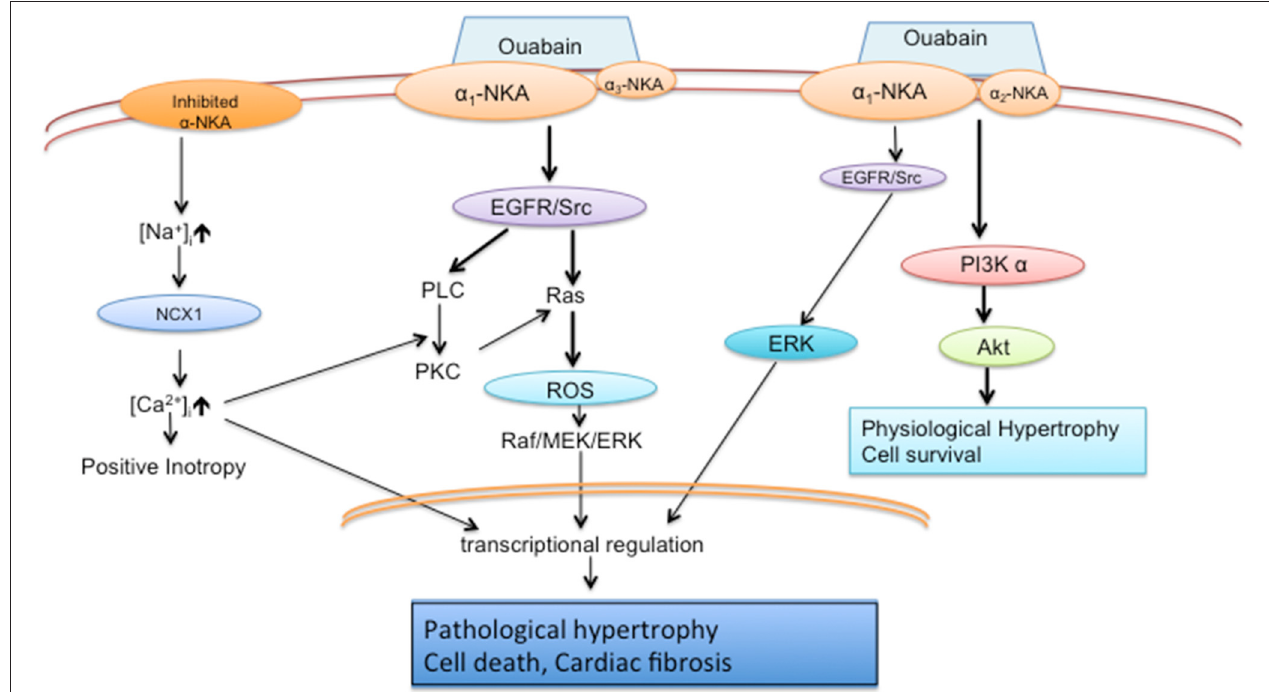
FIGURE 1 | Schematic diagram of Na + /K + -ATPase pumping and signaling functions in cardiomyocytes (Liu et al., 2006, 2007; Wu et al., 2015). Inhibited pump alters local [Na + ] i and induces myocytes contractility; Major effect of ouabain signaling is Src/Ras/ROS/ERK cascade in α 1/ α 3 neonatal cardiomyocytes; Major effect of ouabain signaling is PI3K α /Akt pathway in α 1/ α 2 adult cardiomyocytes.